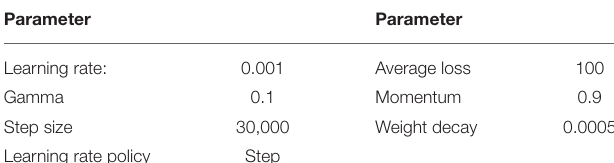
TABLE 2 | Parameters of faster RCNN.